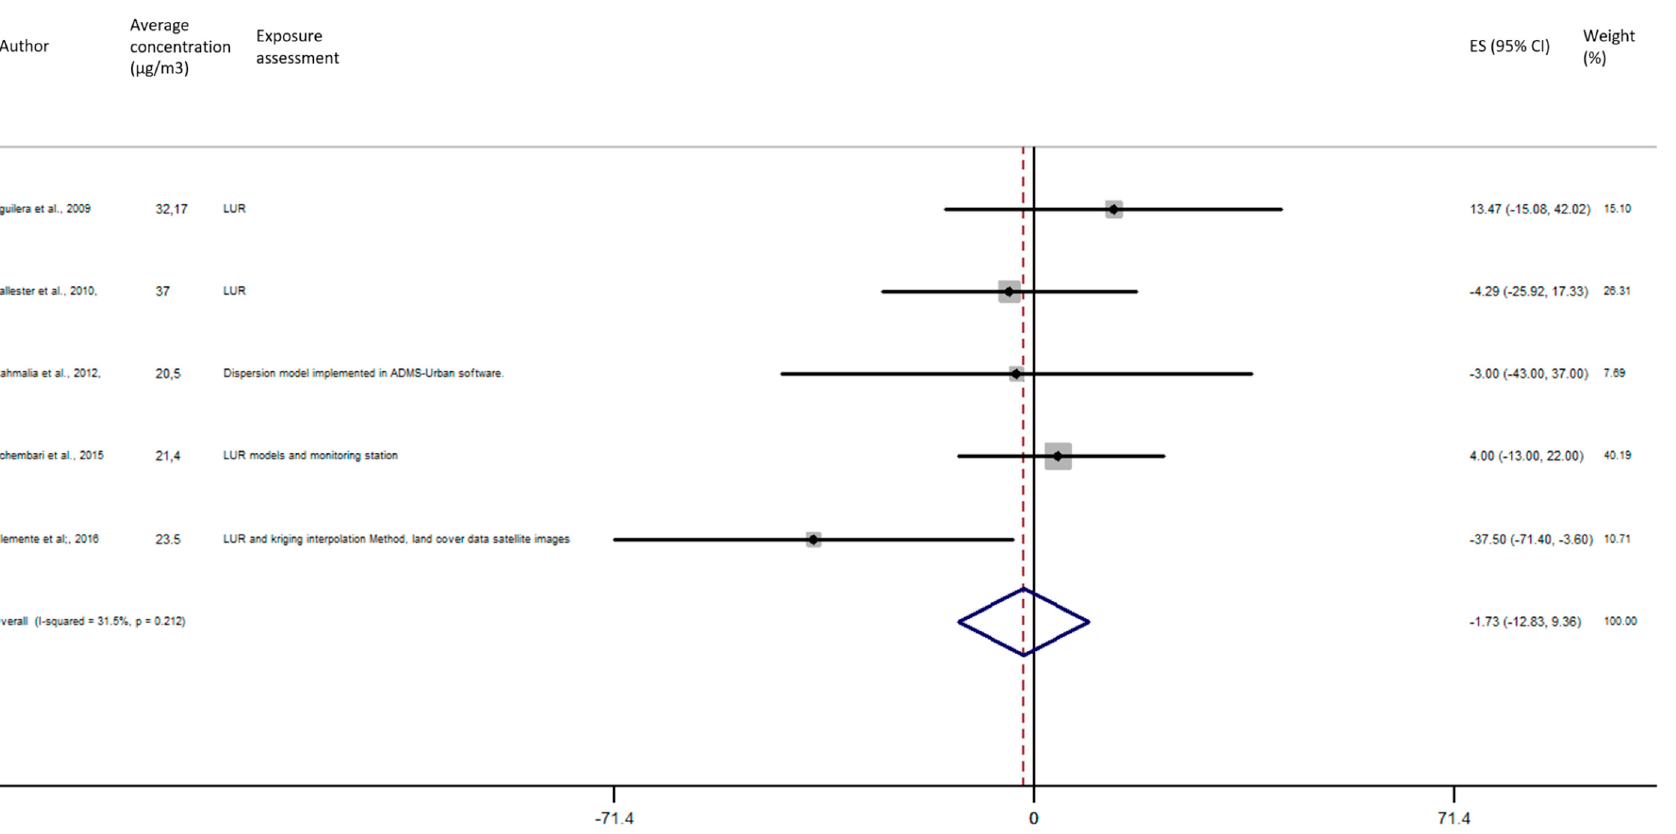
Figure 7. Association between birth weight and NO 2 exposure during the third trimester of pregnancy.